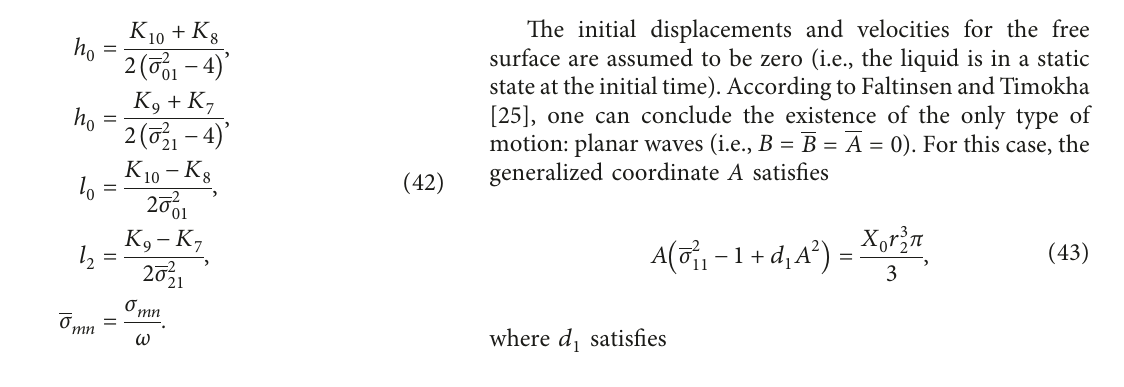
� 0.5m and z � 0 . 1 m 1 1